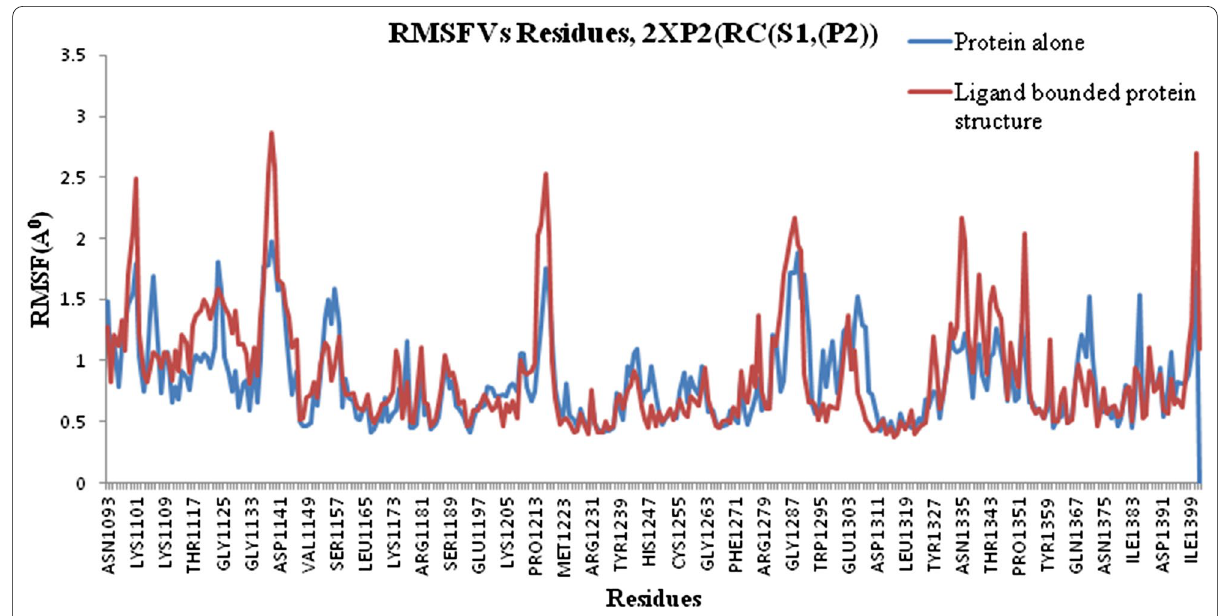
Fig. 8 RMSF graph based on ligand-free protein and ligand bounded protein complex of ALK